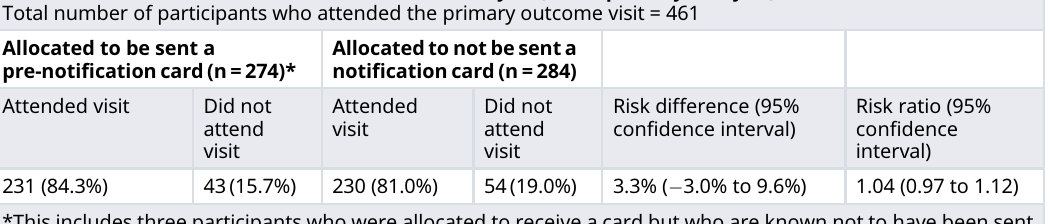
Table 1. Attendance at the 12-month primary outcome measurement visit for those sent a pre-notification card and those not sent a card. Attendance at 12-months – Intention-to-treat analysis (SWAT primary analysis) Total number of participants who attended the primary outcome visit = 461 Allocated to be sent a